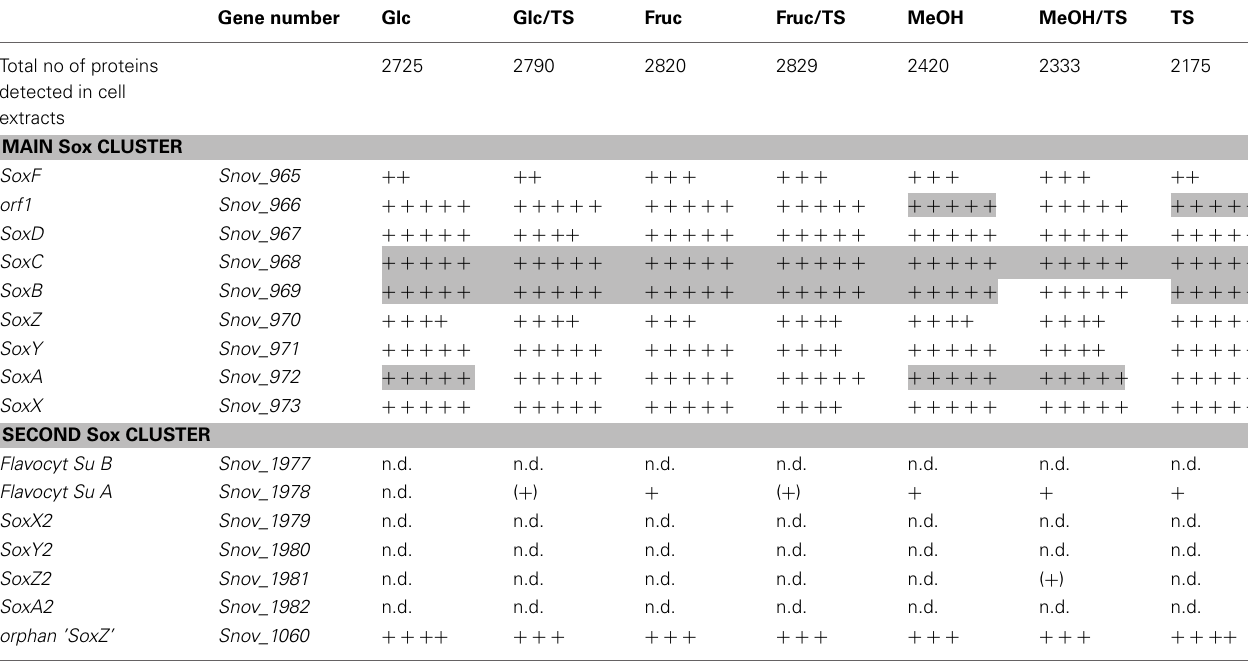
Table 2 | Presence of proteins involved in sulfur chemolithotrophy in S. novella cell extracts from chemolithoautotrophic, methylotrophic, heterotrophic, and mixotrophic growth